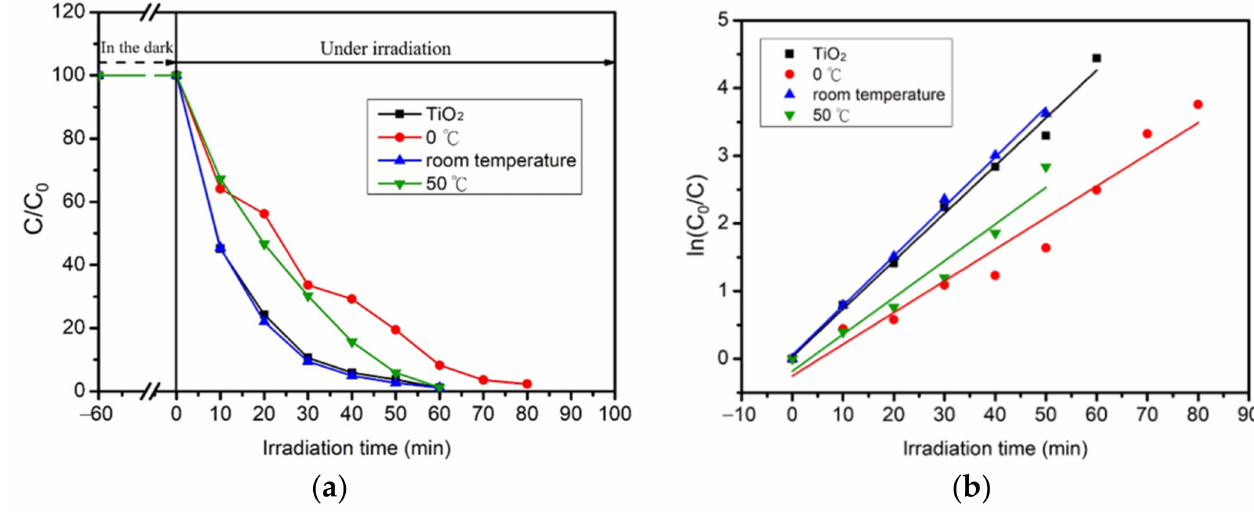
Figure 11. ( a ) Photodegradation of Cu/TiO 2 at different reaction temperatures; ( b ) Photocatalytic activities of Cu/TiO 2 at different reaction temperatures by plotting ln(C 0 /C) versus irradiation time